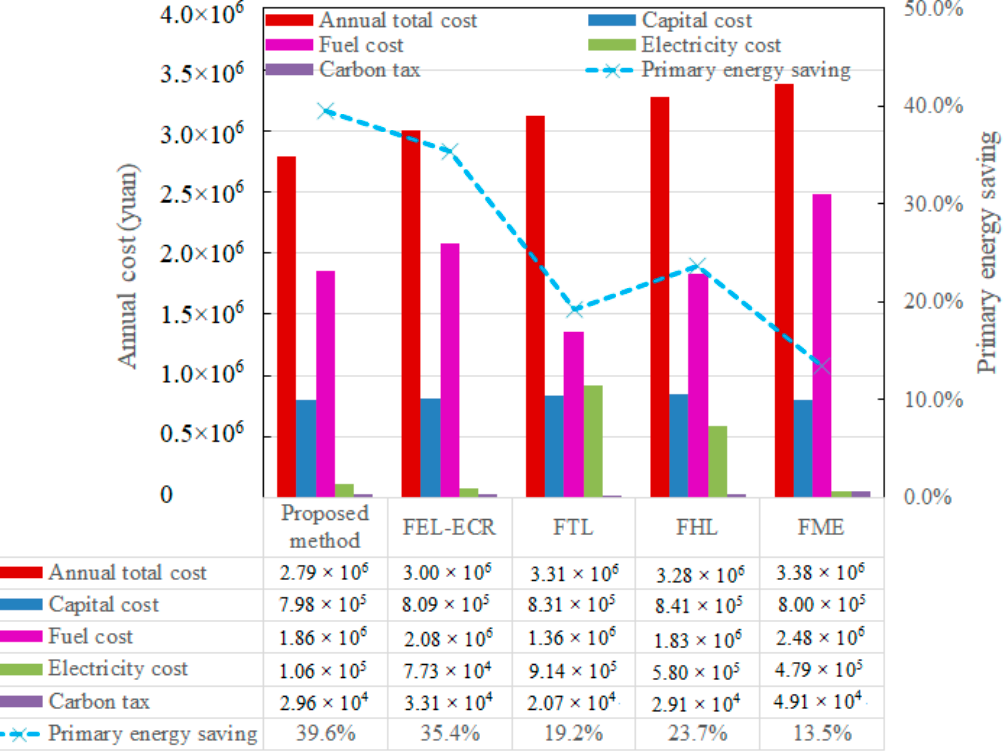
ff erent operation